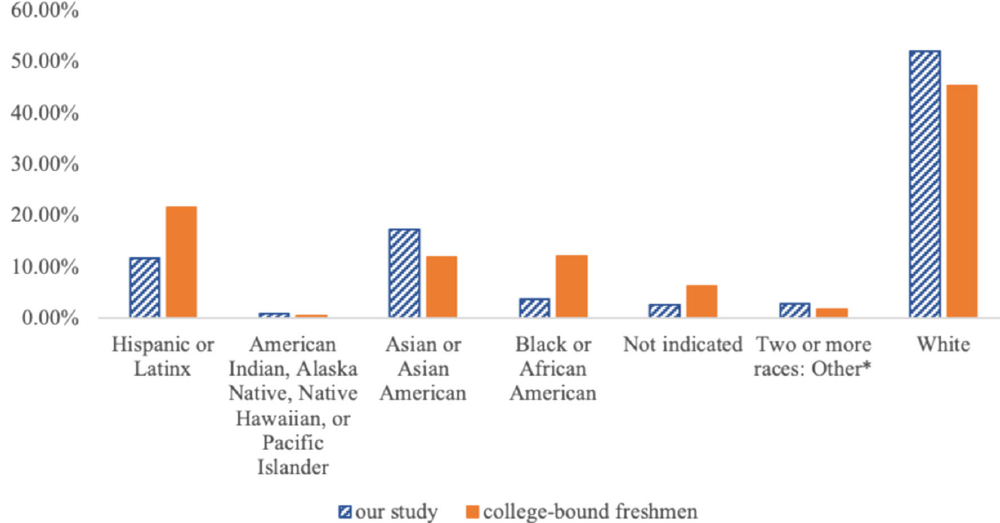
FIG. 9. Racial and/or ethnic demographics of our sample versus college-bound freshmen. Orange bars were constructed from percentages cited in Kanim and Cid [22]; blue striped bars were constructed from publicly accessible university-level demographic data, weighted by sample size.